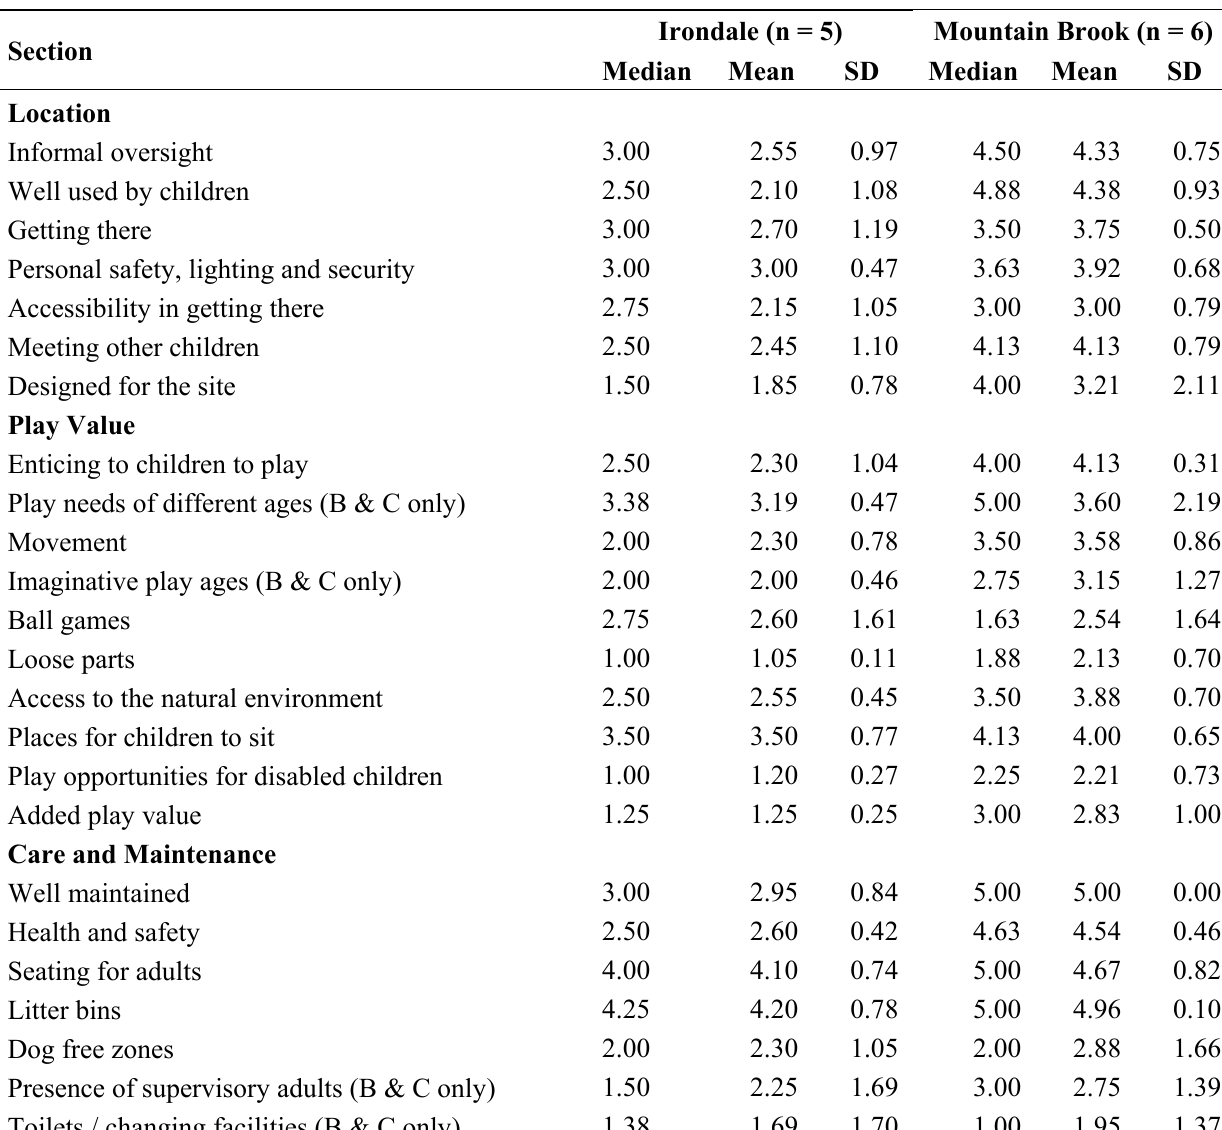
Table 2. Playable Space Quality Assessment Tool scores on park quality of the two study